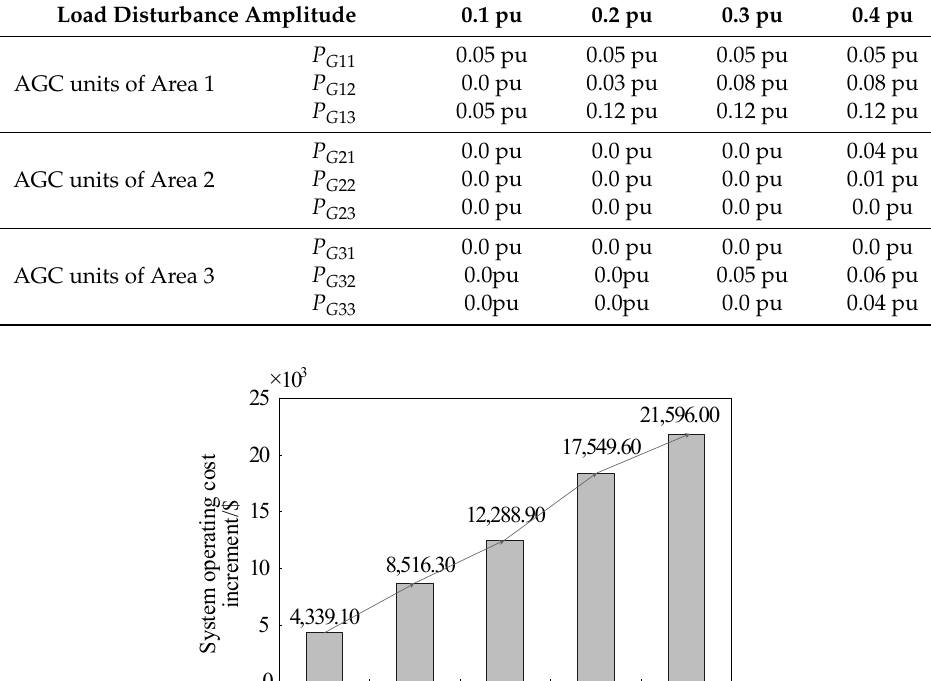
Table 4. Power allocation of AGC units under different load step disturbances.